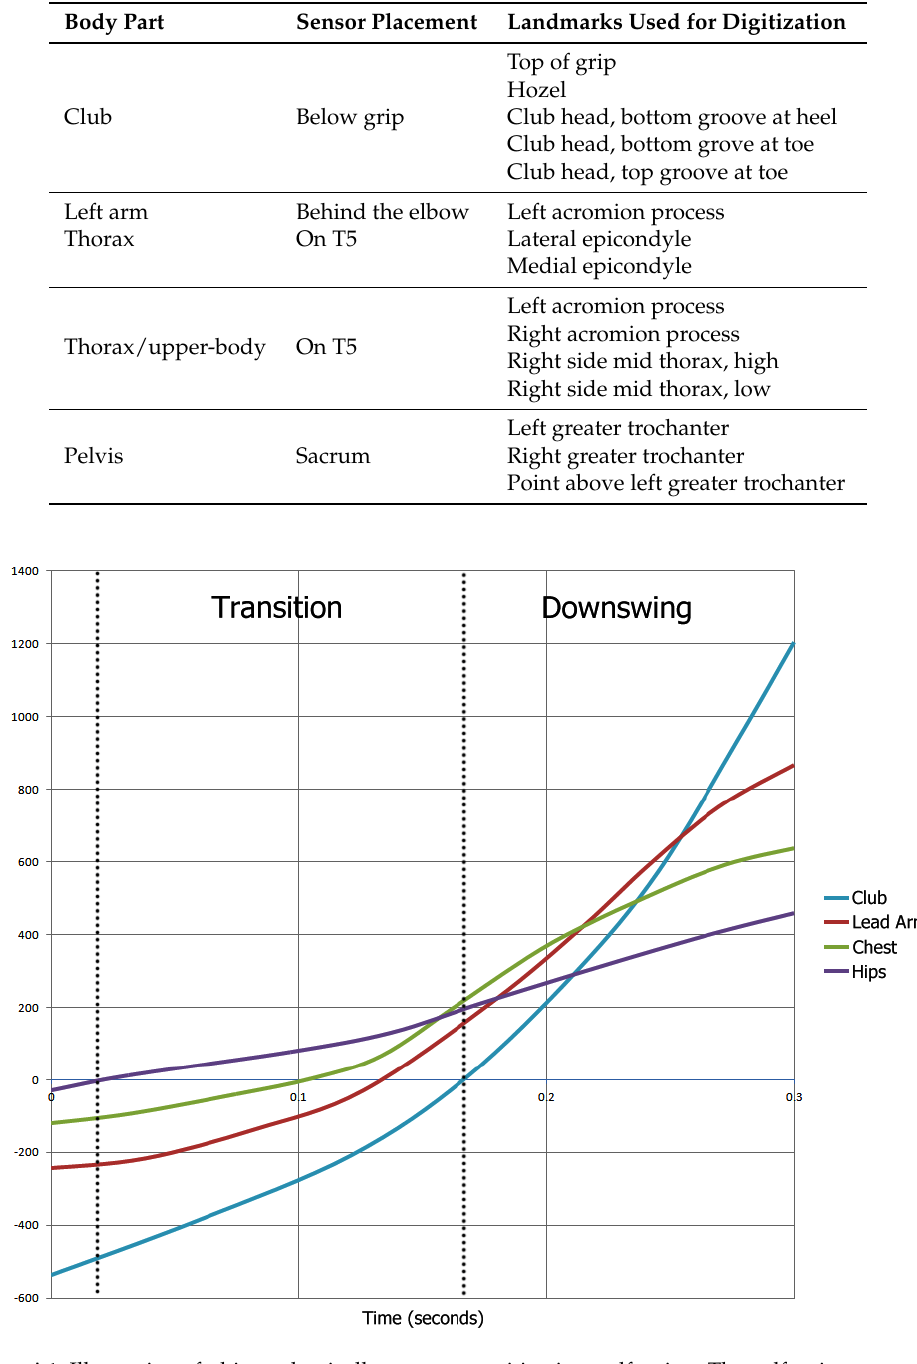
Figure A1. Illustration of a biomechanically-correct transition in a golf swing. The golf swing progresses in time on the X (horizontal) axis from left to right, and the speed of player’s body parts is on the Y (vertical)